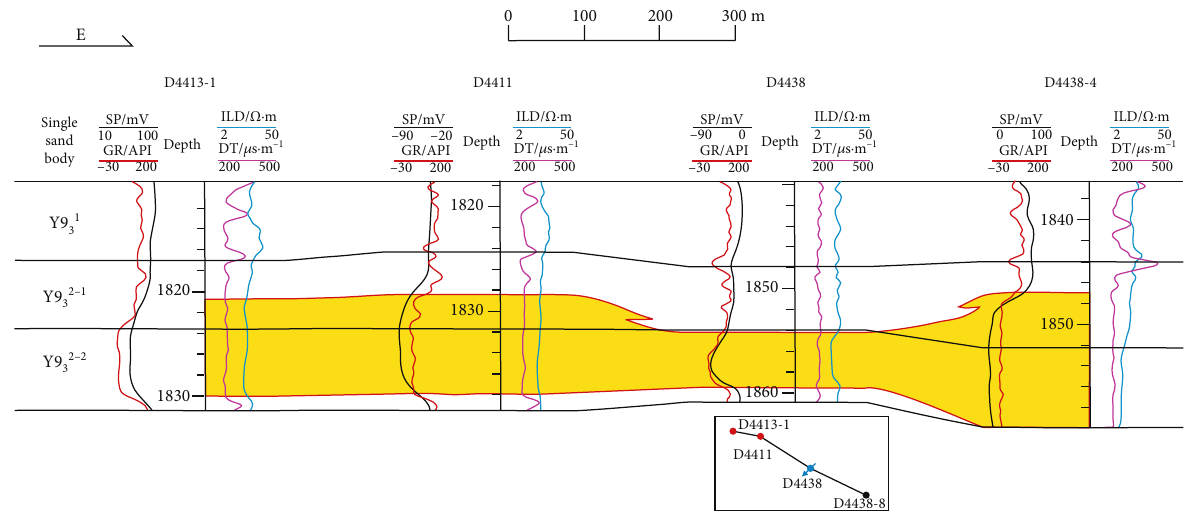
Figure 9: Schematic diagram of the logging curve change.